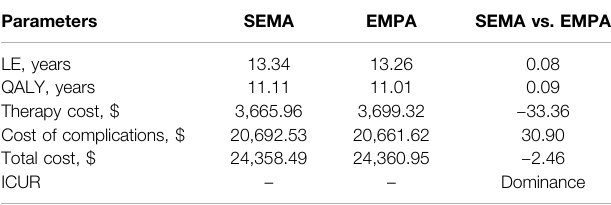
TABLE 5 | The results of cost-utility analysis at the condition of C 0 (cid:2) C SEMA (cid:2) C EMPA (cid:2)